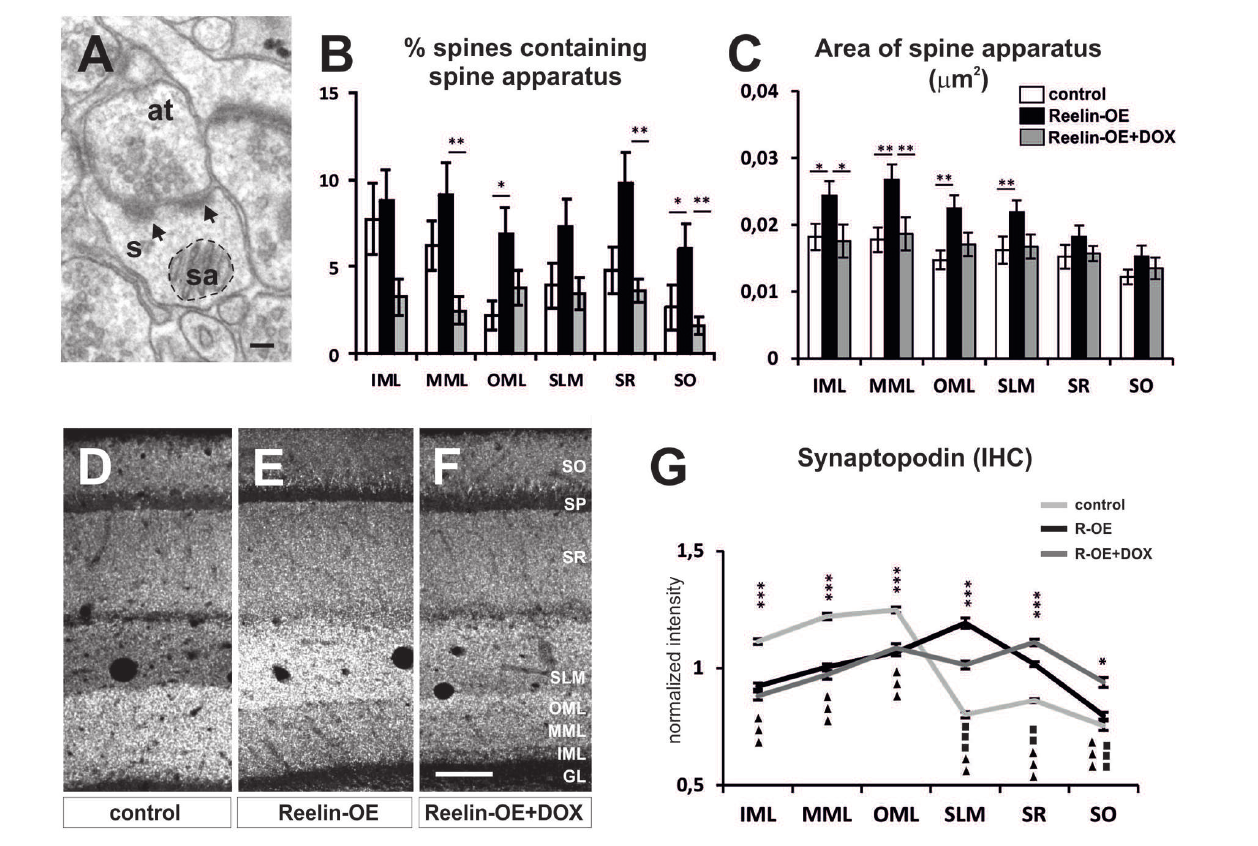
FIGURE 3 | Spine apparatus and Synaptopodin in dendritic spines of Reelin-OE mice. (A) Electron micrograph of dendritic spines (s) containing a spine apparatus (sa) and receiving two synaptic contacts (arrows) from an axon terminal (at). Dashed-line circle represents an example of the area of spine apparatus used to perform analysis in (C) . (B,C) Histograms illustrating the percentage of dendritic spines containing spine apparatus (B) and the area of these organelles (C) in distinct hippocampal layers of control, Reelin-OE, and DOX-treated Reelin-OE mice (mean ± SEM; ∗ p < 0.05, ∗∗ p < 0.01; ANOVA test). (D–F) Immunolabeling for Synaptopodin in hippocampal sections of control, Reelin-OE, and DOX-treated Reelin-OE mice. (G) Quantitative determination of immunofluorescence signals in control, Reelin-OE, and Reelin-OE + DOX mice. Diagram shows continuous linear profiles of fluorescence intensities in vertical stripes of hippocampal sections from the stratum oriens to the granule layer for Synaptopodin. The intensity of fluorescence is represented in gray levels (mean ± SEM; ∗ p < 0.05, ∗∗ p < 0.01, ∗∗∗ p < 0.001 for control vs. Reelin-OE mice; squares for Reelin-OE vs. Reelin-OE + DOX; triangles for control vs. Reelin-OE + DOX mice; ANOVA test). GL, granular layer; IHC, immunohistochemistry; IML, inner molecular layer; MML, medial molecular layer; OML, outer molecular layer; SLM, stratum lacunosum-moleculare; SO, stratum oriens; SP, stratum pyramidale; WB, western blot. Scale bars, (A) = 100 nm; (F,G) = 100 µ